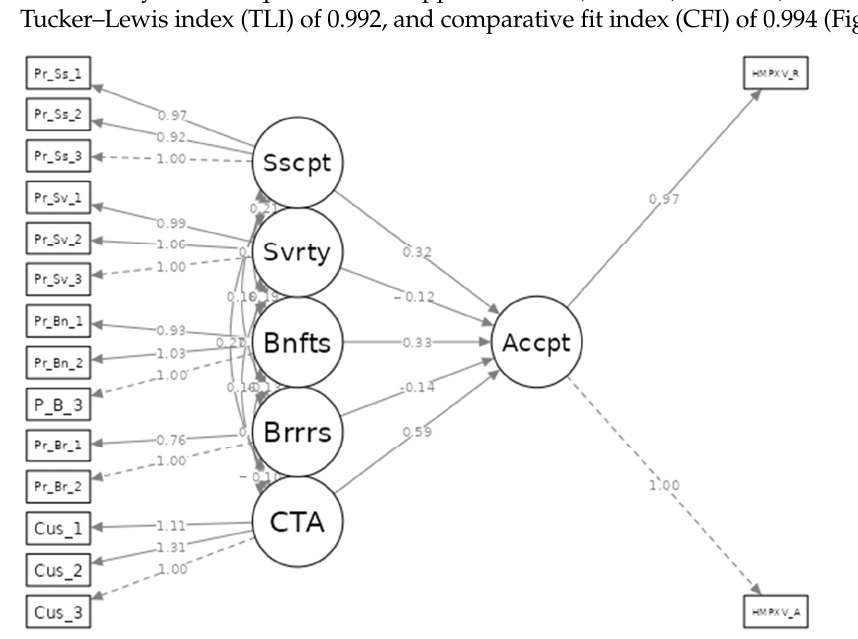
Figure 2. Structural equation model (SEM) of Czech HCWs’ perceptions and acceptance of HMPXV vaccines, September 2022 ( n = 341). Sscpt = perceived susceptibility. Svrty = perceived severity. Bnfts = perceived benefits. Brrrs = perceived barriers. CTA = cues to action. Accpt = Acceptance. HMPXV vaccine_R = recommendation. HMPXV vaccine_A = acceptance.